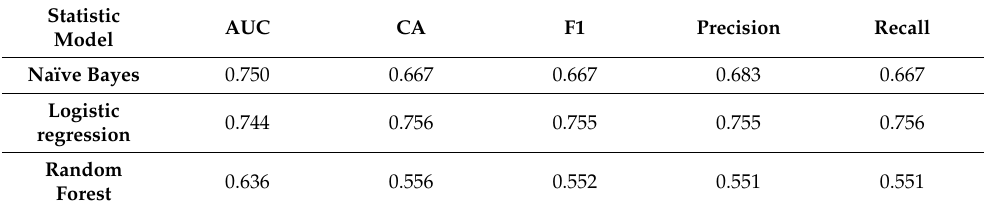
Table 4. Head-to-head comparison of the area under the curve results for the classification accuracy yielded by the five metabolites using three supervised classification algorithms.